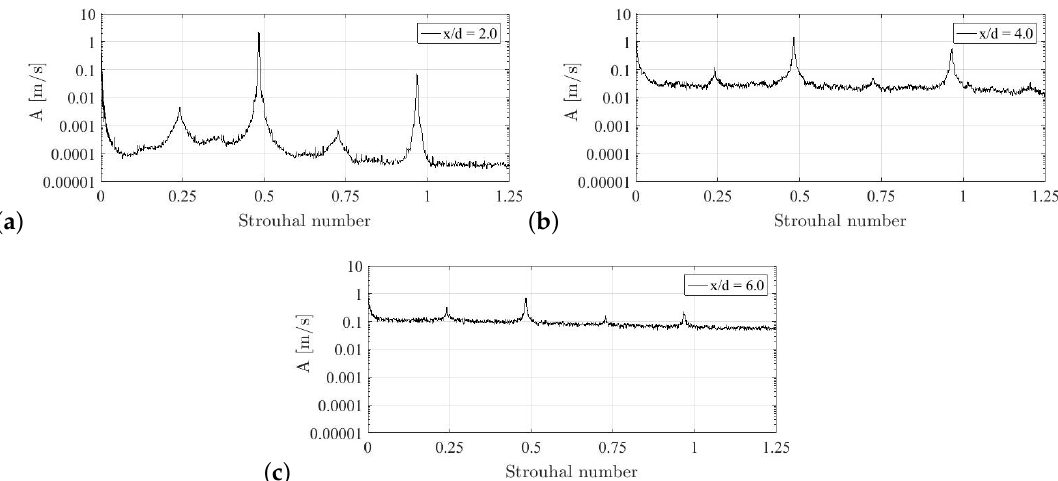
Figure 14. Evolution of spectra of axial velocity fluctuations, S = 0.5, L / D = 15, Re =